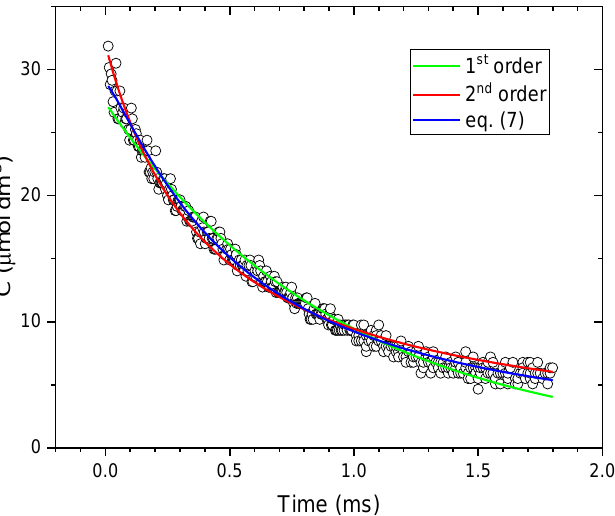
Figure 5. Pulse radiolysis of Ar-saturated aqueous solution containing 50 mmol dm − 3 PAA, pH 2, dose per pulse 62 Gy, average initial number of radicals on a chain 1.64. Experimental data on the decay of the PAA radicals and the fits based on three kinetic models: classical first- and second-order, and dispersive model (Plonka model, Equation (7)).